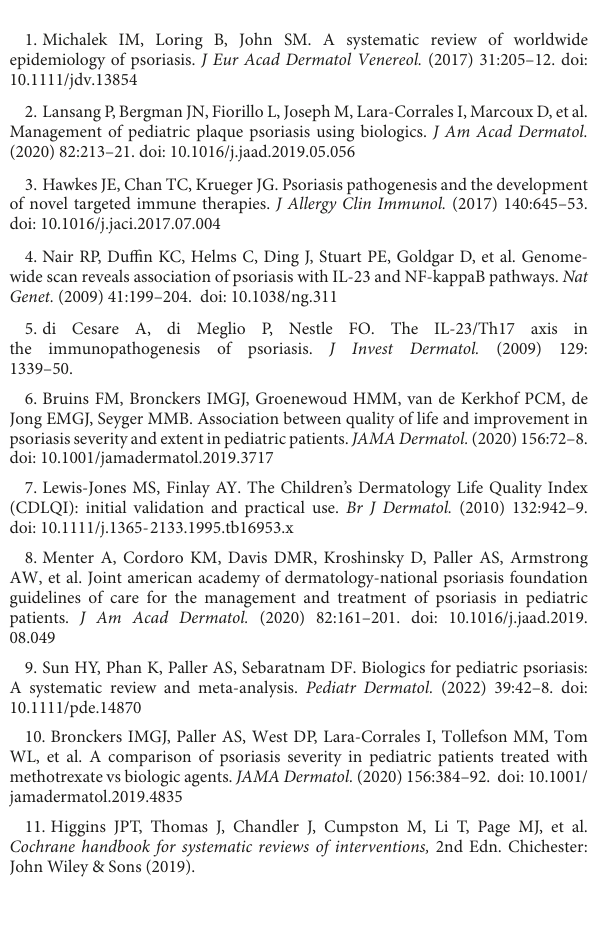
SUPPLEMENTARYFIGURE2 Funnel plots asymmetry tests, using data from pediatric psoriasis studies (A) PASI75 data (B) PASI90 data, with log-risk ratios displayed on the horizontal axis. PASI, Psoriasis Area and Severity